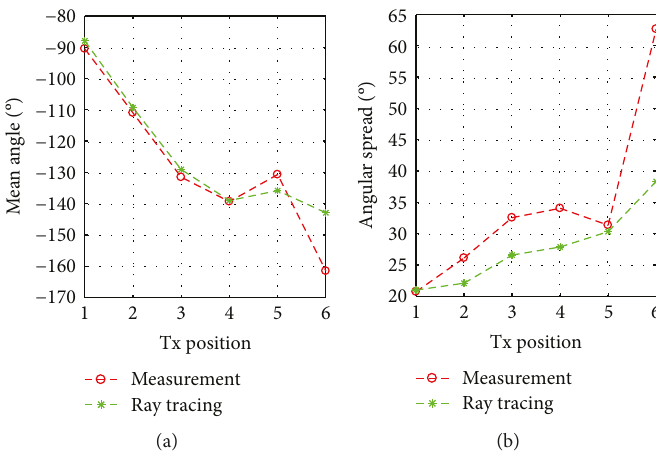
Figure 15: Measured and RT-simulated mean angles (a) and angle spread (b) for all Tx positions for the basement scenario.